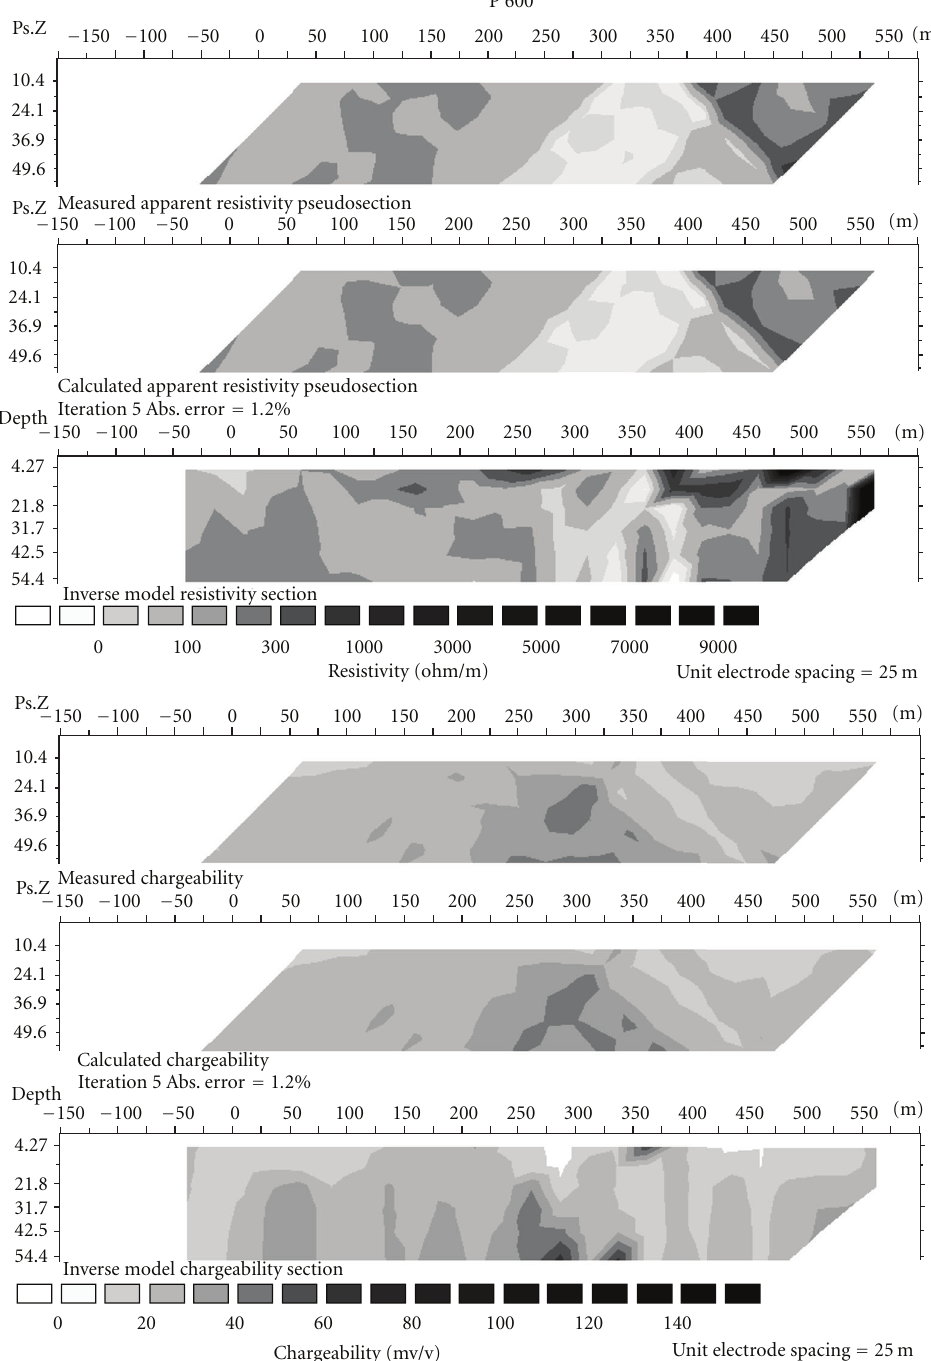
Figure 3: Measured and calculated apparent pseudosections and inverse models sections of resistivity and chargeability for no. 600 Pur´ısima